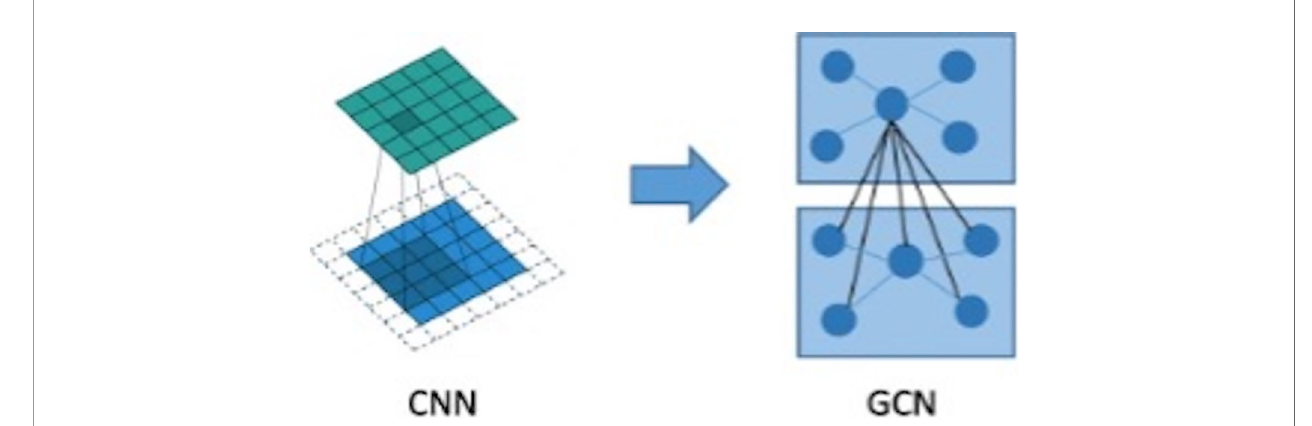
FIGURE 5 | Generalization from image spatial convolution to graph convolutional